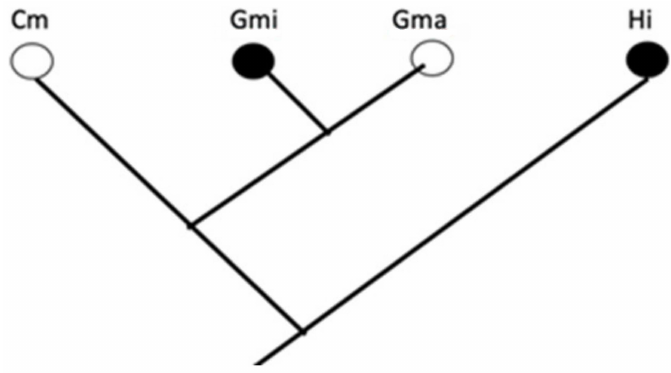
Figure 2. Phylogenetic relationships of the four study